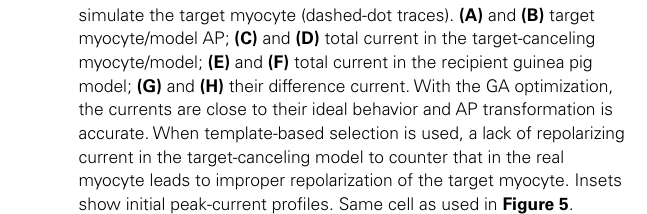
simulate the target myocyte (dashed-dot traces). (A) and (B) target myocyte/model AP; (C) and (D) total current in the target-canceling myocyte/model; (E) and (F) total current in the recipient guinea pig model; (G) and (H) their difference current.With the GA optimization, the currents are close to their ideal behavior and AP transformation is accurate.When template-based selection is used, a lack of repolarizing current in the target-canceling model to counter that in the real myocyte leads to improper repolarization of the target myocyte. Insets show initial peak-current profiles. Same cell as used in Figure 5